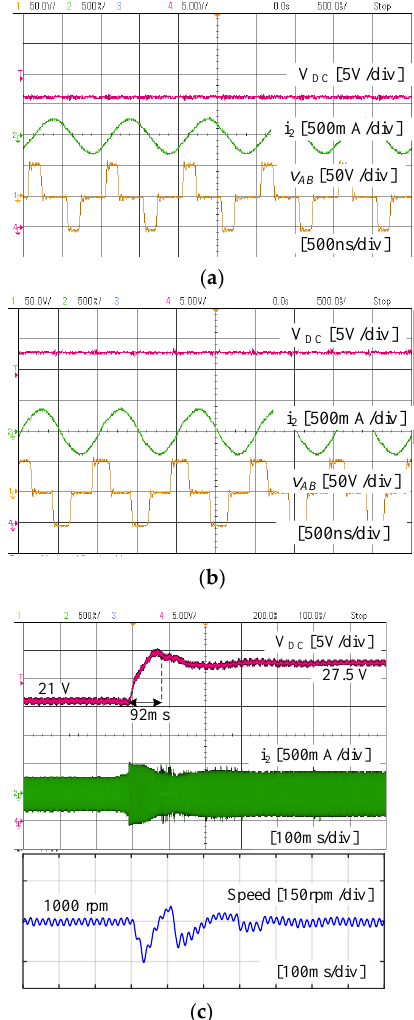
Figure 15. MET strategy for K = 0.5 ( a ) steady-state waveforms of the WPTS at P o = 2.5 W ( b ) steady-state waveforms of the WPTS at P o = 5 W ( c ) transient waveform of the system at P o step change from 2.5 W to 5 W.